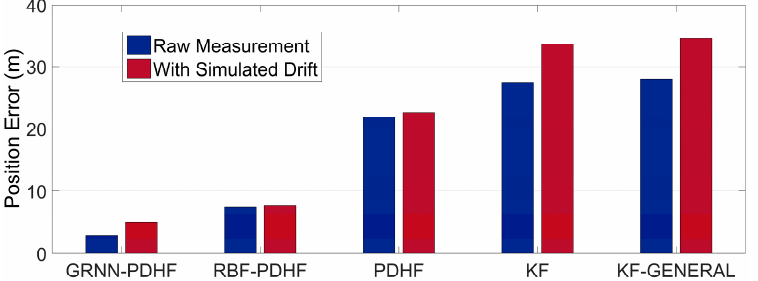
Figure 11. Maximum position error during outage 3 in trajectory 1 while using raw measurement and with extra simulated uncertain nonlinear drift.